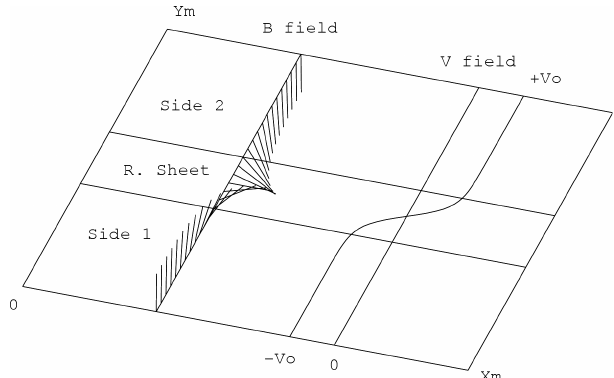
Fig. 1. Schematic view of initial magnetic field and velocity used in the